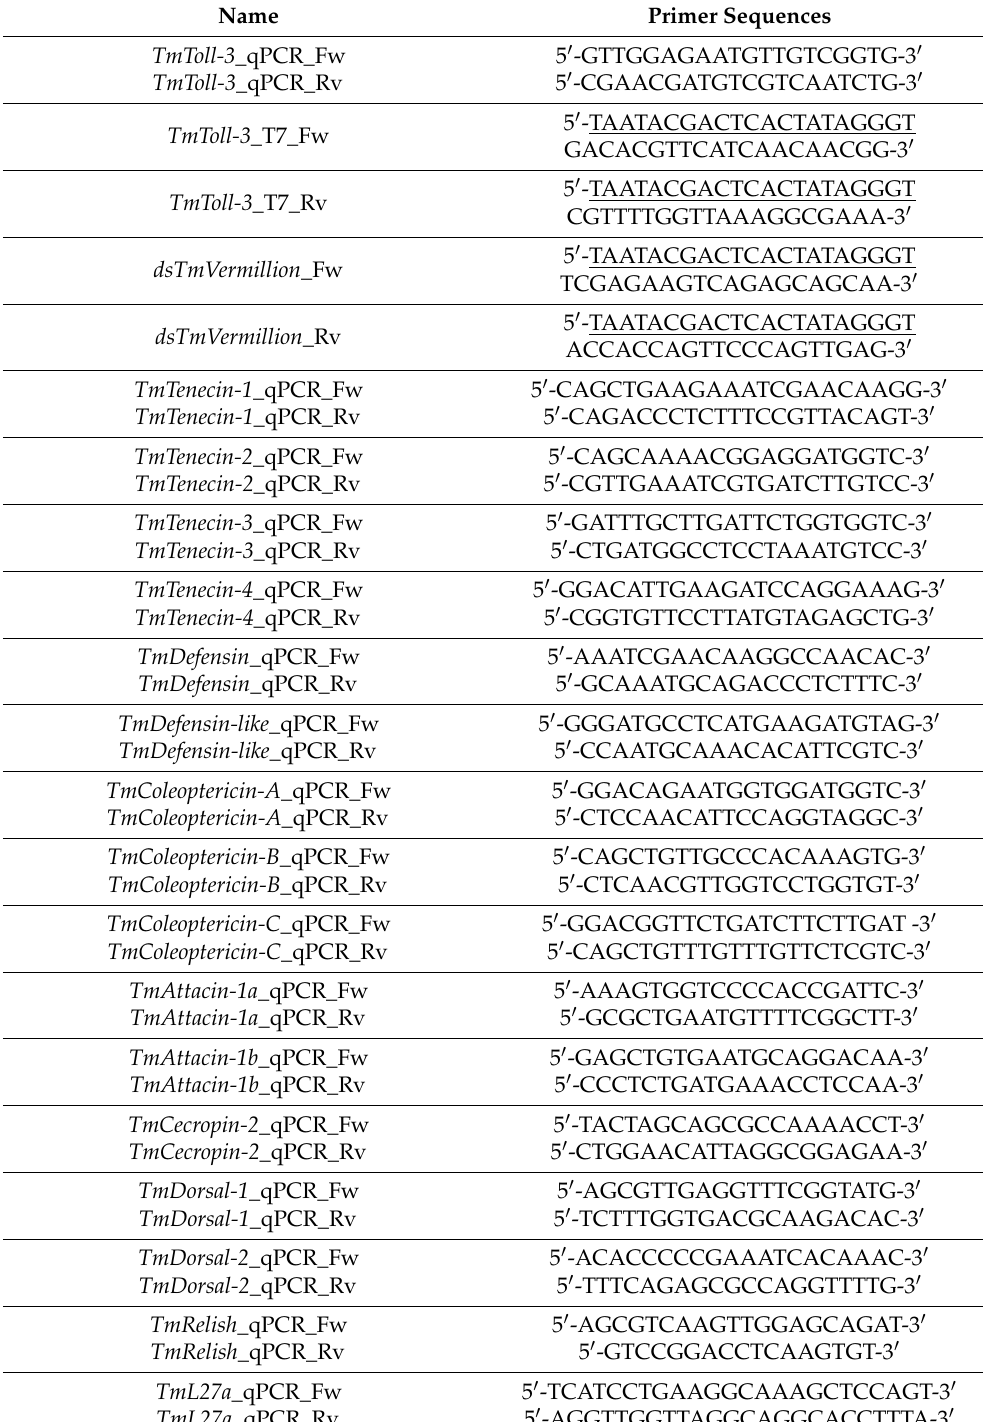
Table 1. Sequences of the primers used in this